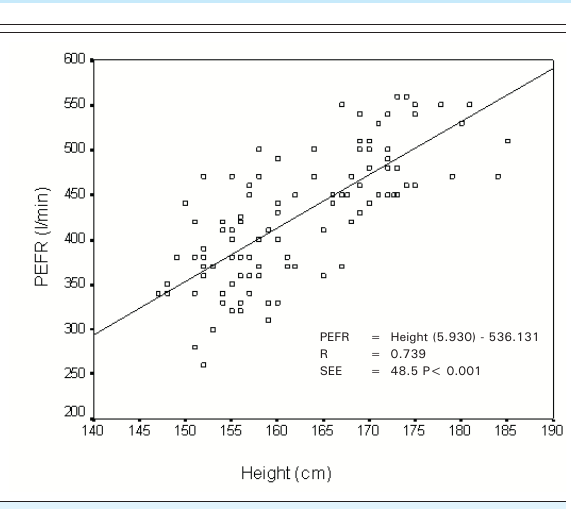
Figure 1. Linear regression analysis depicting the prediction of PEFR from height of the Indian and Nepalese young adults (reduced combined data. N=117) the prediction equation is changed to: PEFR = 5.930 × Height (cm) –